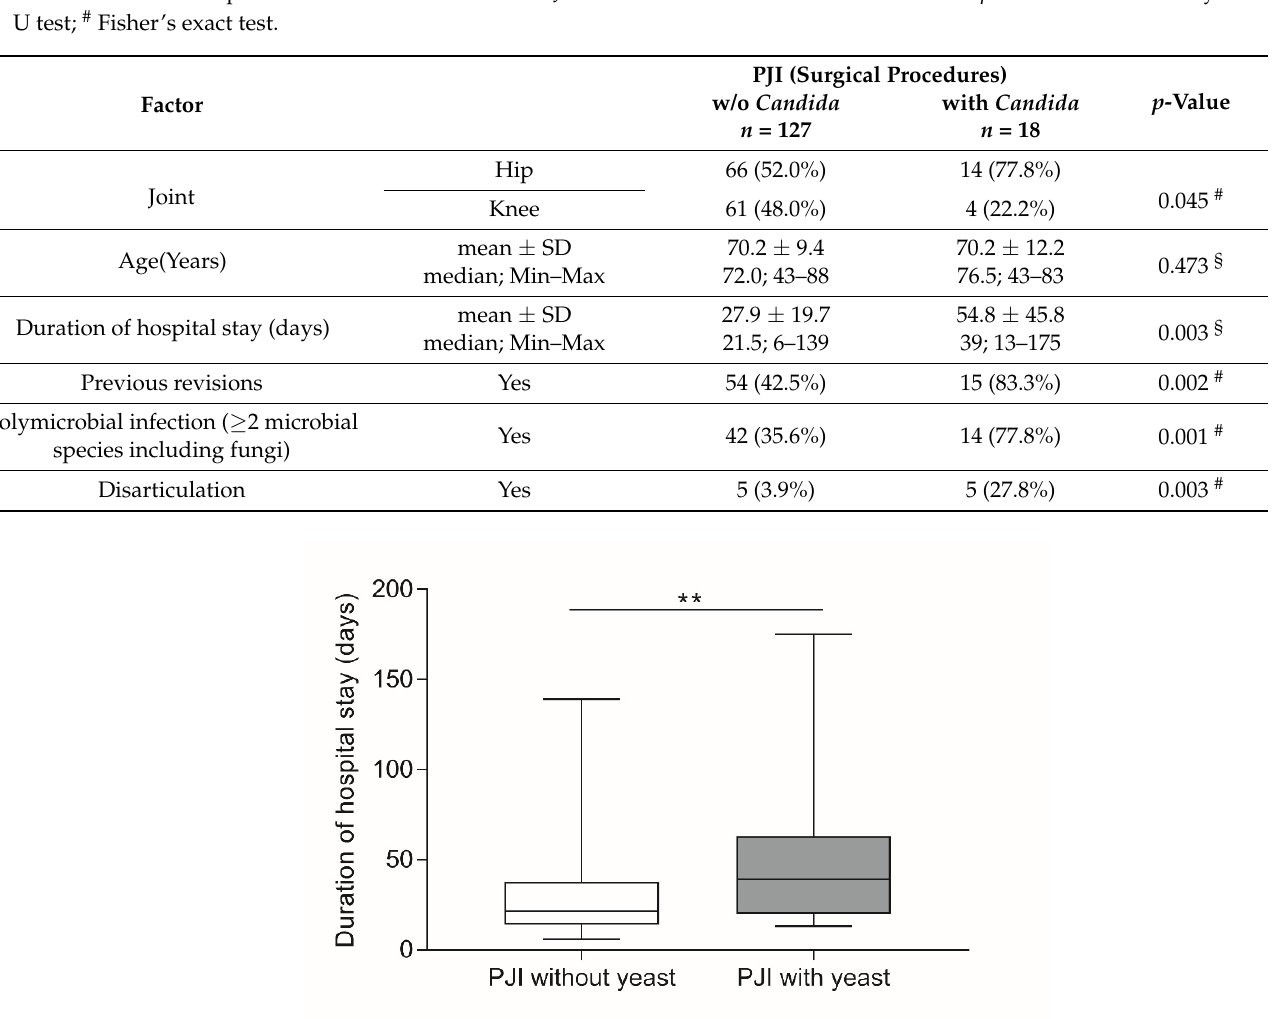
Table 3. Overview of patient and microbial factors in PJI without and with detection of a Candida species . § Mann–Whitney U test; # Fisher’s exact test.